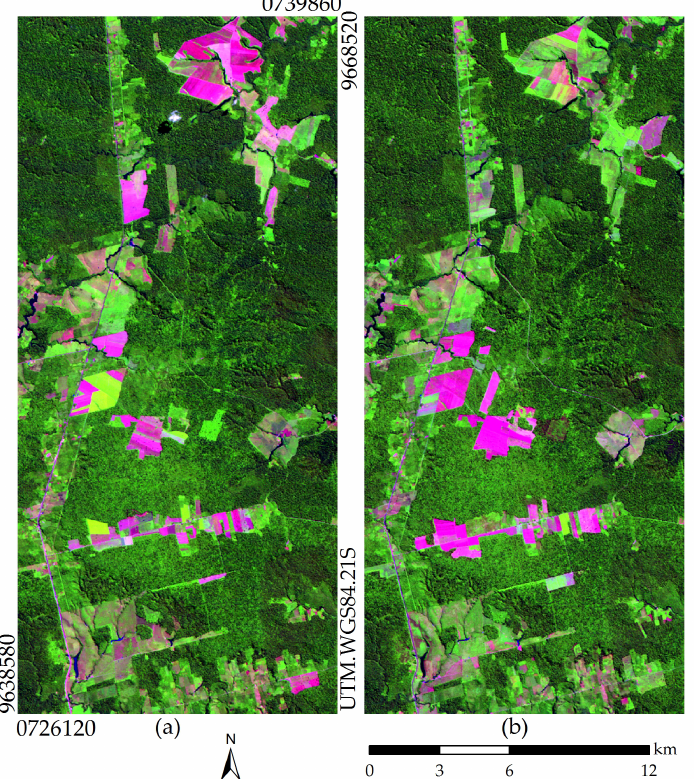
Figure 4. Images: ( a ) LANDSAT5/TM image from 23 June 2008 5(R)4(G)2(B); ( b ) LANDSAT5/TM image from 29 June 2010